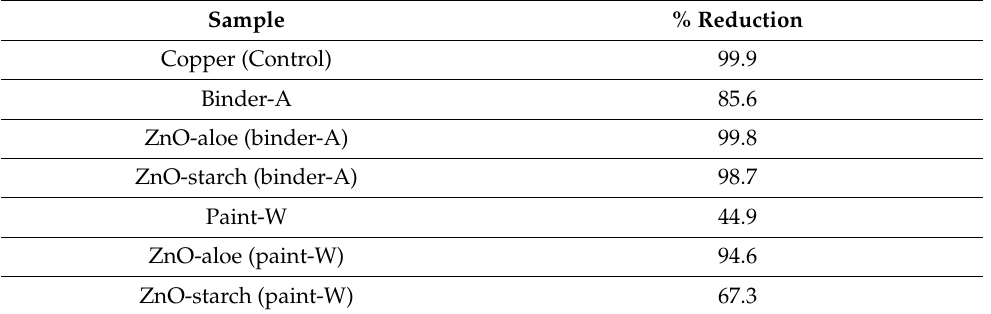
Figure 8. Amplification plots showing normalized reporter values ( Δ Rn, linear scale) as a function of the qPCR cycle for the surfaces loaded with ZnO-aloe and ZnO-starch particles using ( a ) acrylic binder (binder-A) and ( b ) white paint (paint-W) after seven days of the curing process. The amplification plot displays the product accumulation over the real-time PCR experiment based on the fluorescent signal from each sample and the cycle number. Table 1. Decrease of viral load of samples and controls after 24 h of exposure determined by RT-qPCR.